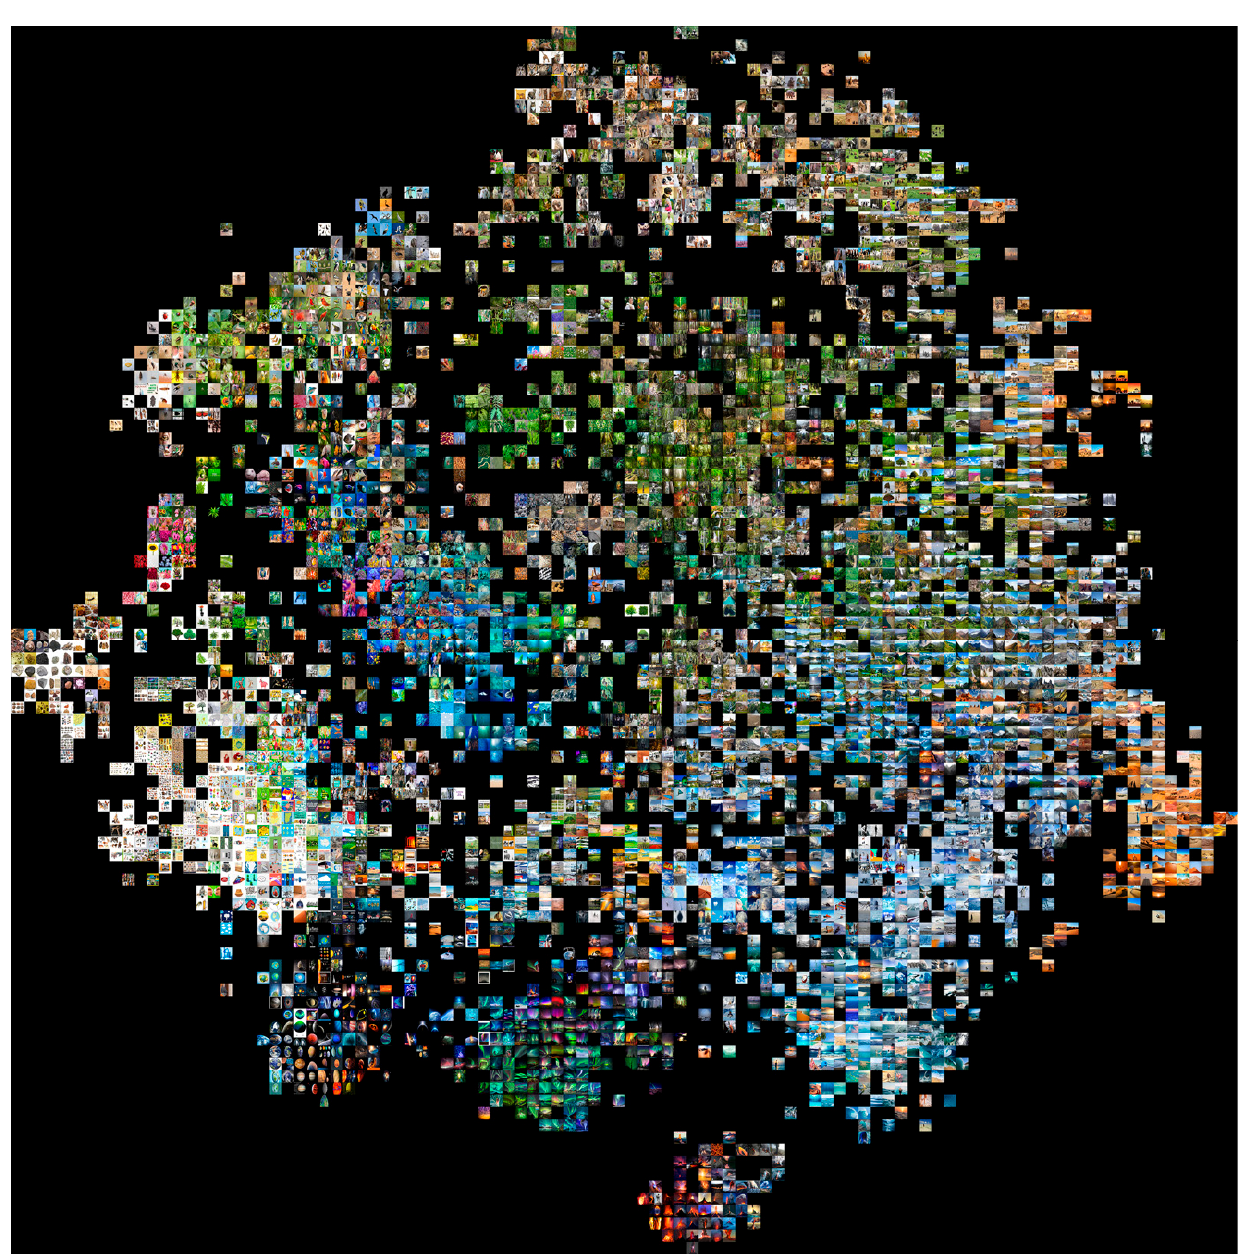
Figure 2. Digital image of 2 × 2 m containing 10,000 images ordered using the artificial network ResNet-50 and the t-SNE algorithm. © Pilar Rosado.